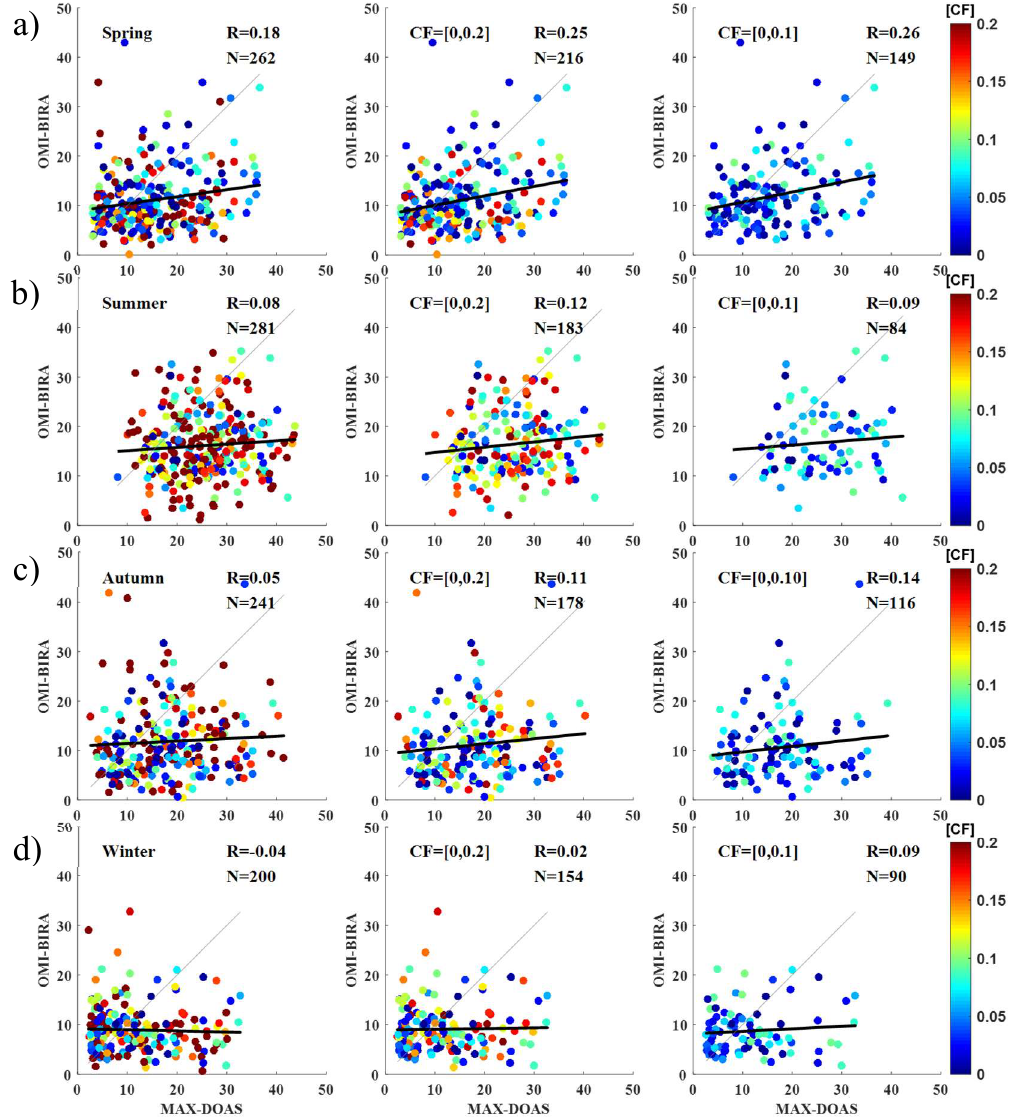
Figure A1. Daily comparisons of OMI-BIRA and MAX-DOAS; left panels: 0 ≤ eCF ≤ 30%, middle panels: 0 ≤ eCF ≤ 20%, right panels: 0 ≤ eCF ≤ 10%. ( a ) Spring (MAM (March-April-May)), ( b ) Summer (JJA (June-July-August)), ( c ) Autumn (SON (September-October-November)), ( d ) Winter (DJF